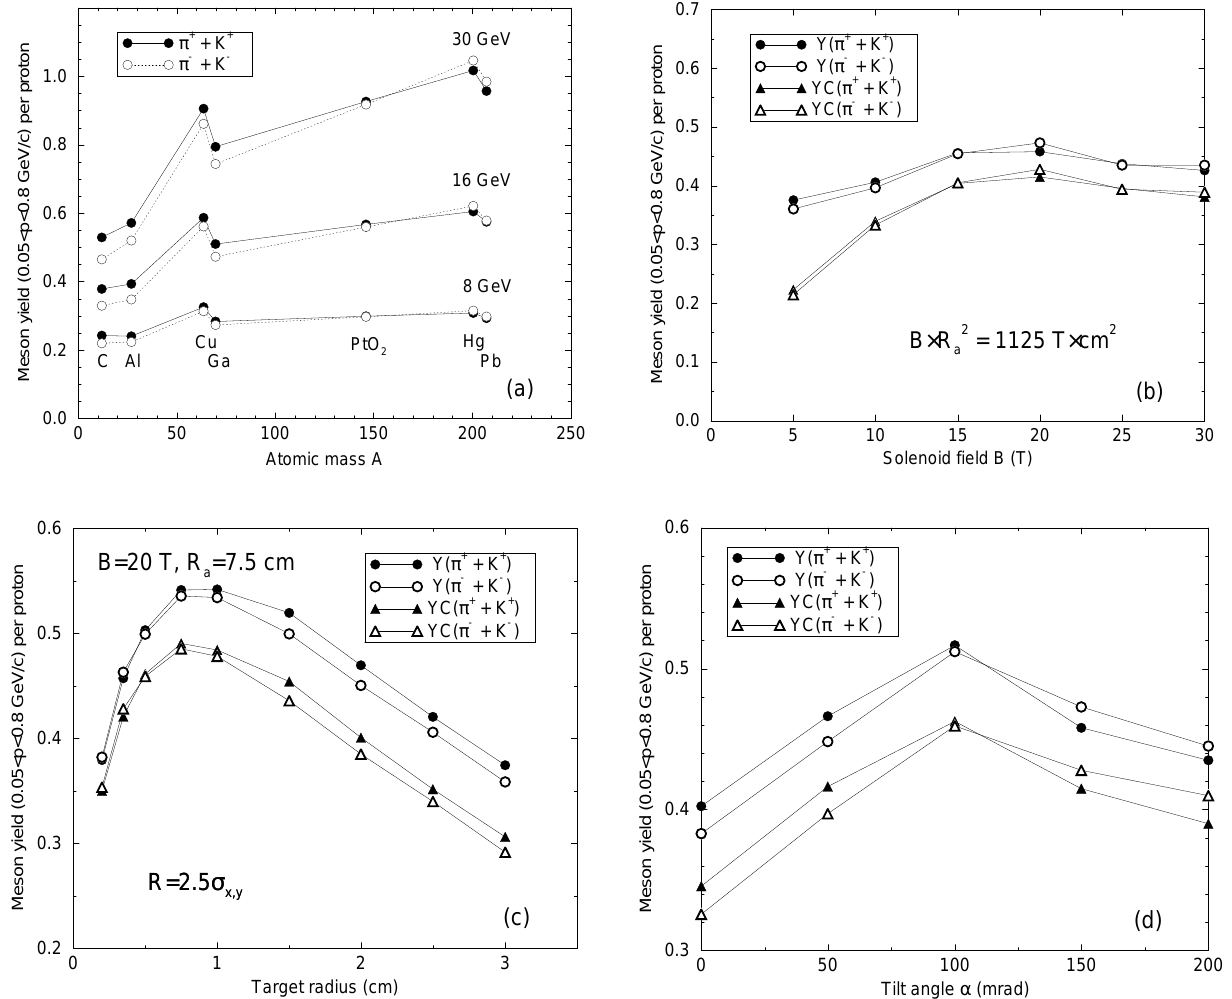
FIG. 16. Meson yield ( p 1 K ) from different targets tilted by angle a in a solenoidal field B of aperture R a as calculated with the MARS13(98) code. The target is aligned along the beam. The curves labeled YC show mesons that are transported into the decay channel. (a) Yield from a 1.5 l I , 1 cm radius target irradiated with 8, 16, and 30 GeV proton beams ( s x (cid:1) s y (cid:1) 4 mm) as a function of target atomic mass ( B (cid:1) 20 T, R a (cid:1) 7.5 cm, a (cid:1) 0 ). (b) Yield from a 3 l I , 1 cm radius gallium target tilted at a (cid:1) 150 mrad in a 16 GeV proton beam ( s x (cid:1) s y (cid:1) 4 mm) vs solenoid field for a fixed adiabatic invariant BR 2 function of radius of a 3 l I gallium target in a 16 GeV proton beam ( s x (cid:1) s y (cid:1) 4 mm, B (cid:1) 20 T, R a (cid:1) 7.5 cm, a (cid:1) 100 mrad). (d) Yield from a 3 l I , 1 cm radius gallium target vs tilt angle between the axis of the capture solenoid and the proton beam for a 16 GeV proton beam (